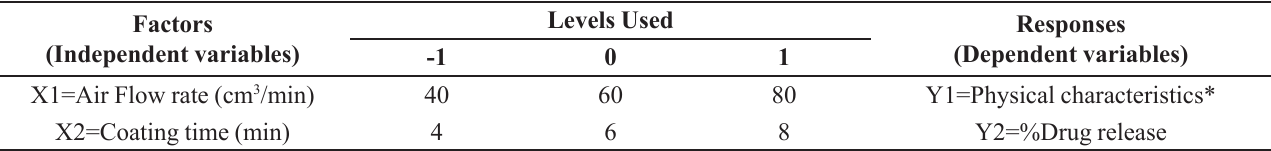
TABLE III - 3 2 full factorial design for methotrexate coated